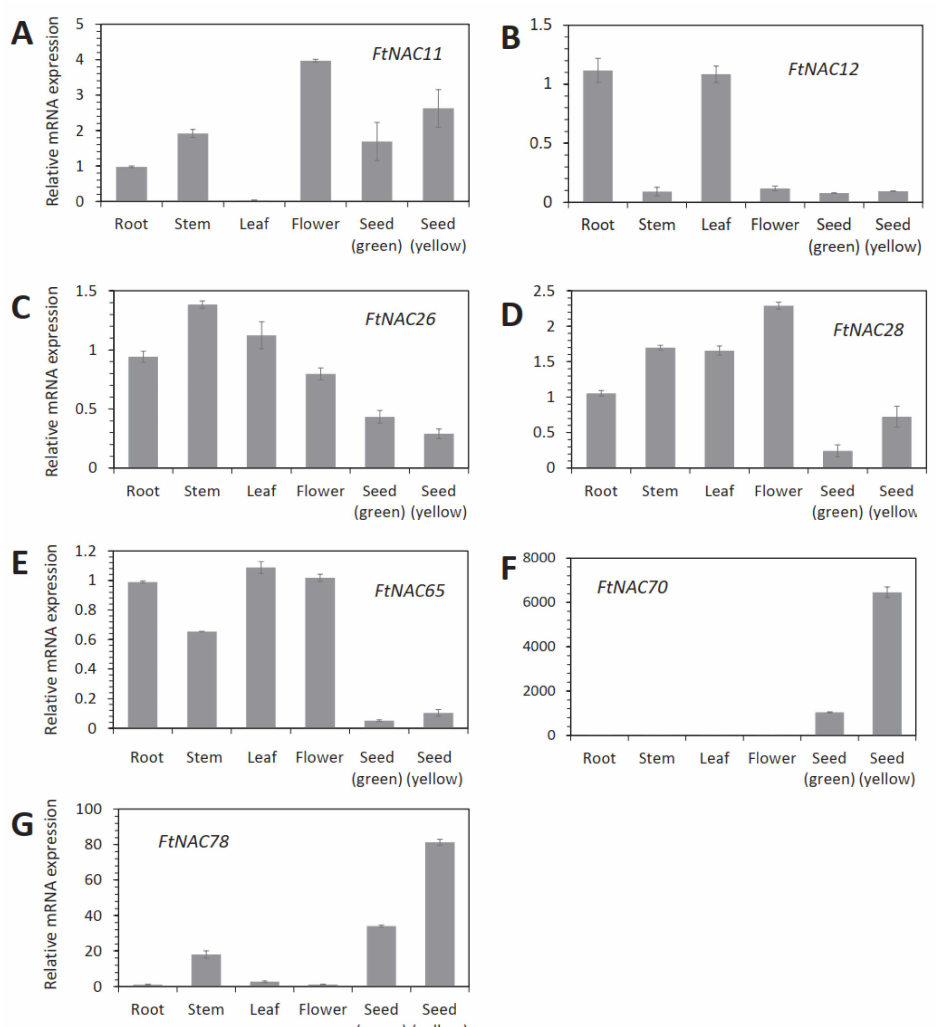
Figure 4. Tissue-specific analyses of seven FtNAC genes, namely FtNAC11 ( A ), FtNAC12 ( B ), FtNAC26 ( C ), FtNAC28 ( D ), FtNAC65 ( E ), FtNAC70 ( F ), and FtNAC78 ( G ). The columns indicate the means of the relative mRNA expression levels. The error bars indicate the standard deviations of the